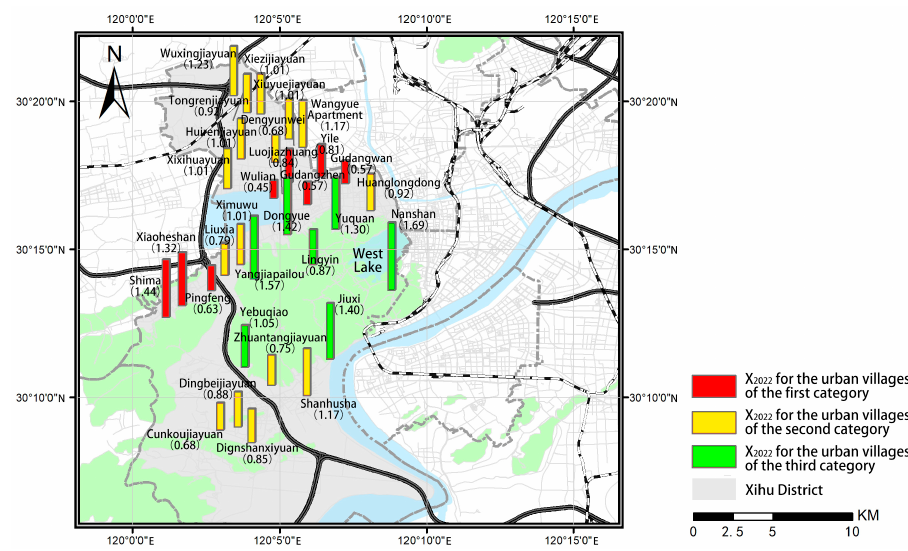
Figure 10. Spatial distribution of X 2022 for the urban villages of the three categories.